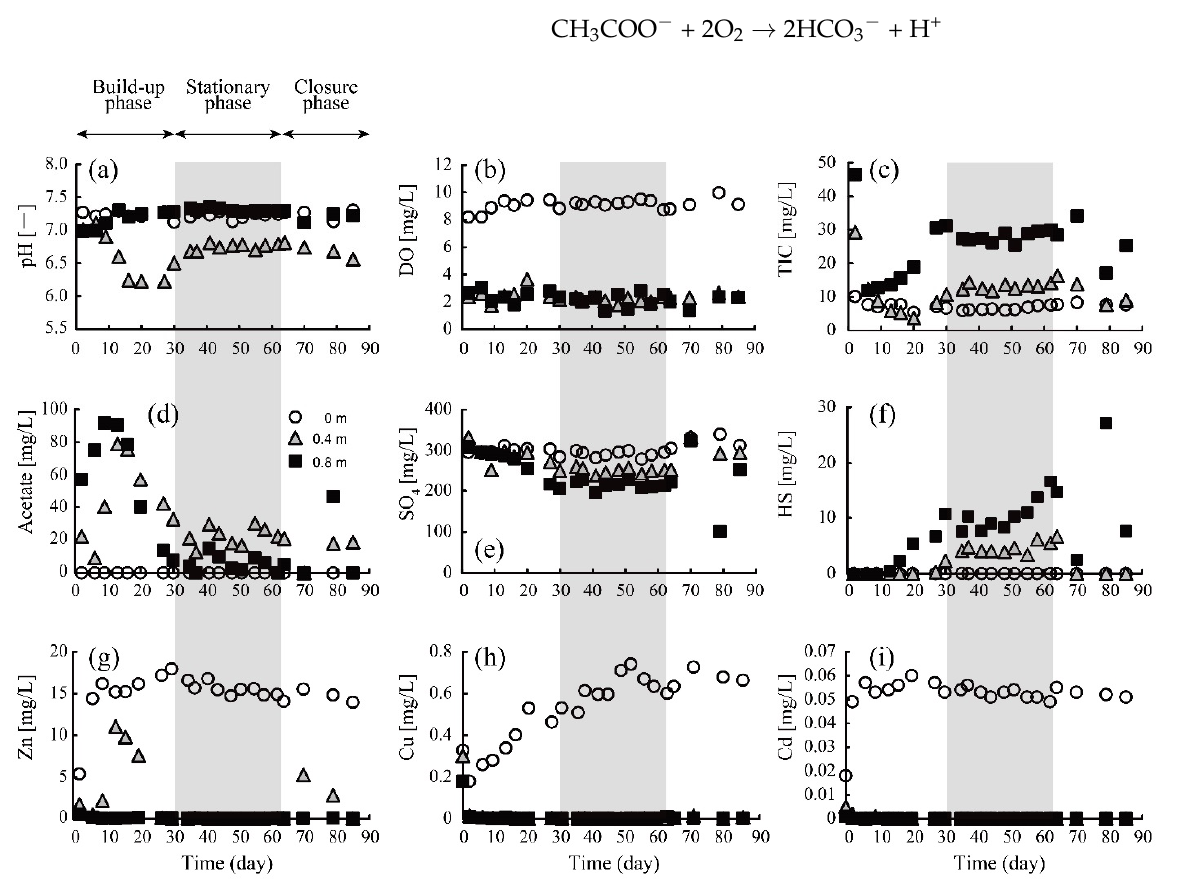
Figure 2. Chronological changes in pH ( a ), and concentrations of DO ( b ), TIC ( c ), acetate ( d ), sulfate ( e ), sulfide ( f ), Zn ( g ), Cu ( h ), and Cd ( i ) at depths of 0 m (top surface of the column), 0.4 m, and 0.8 m.